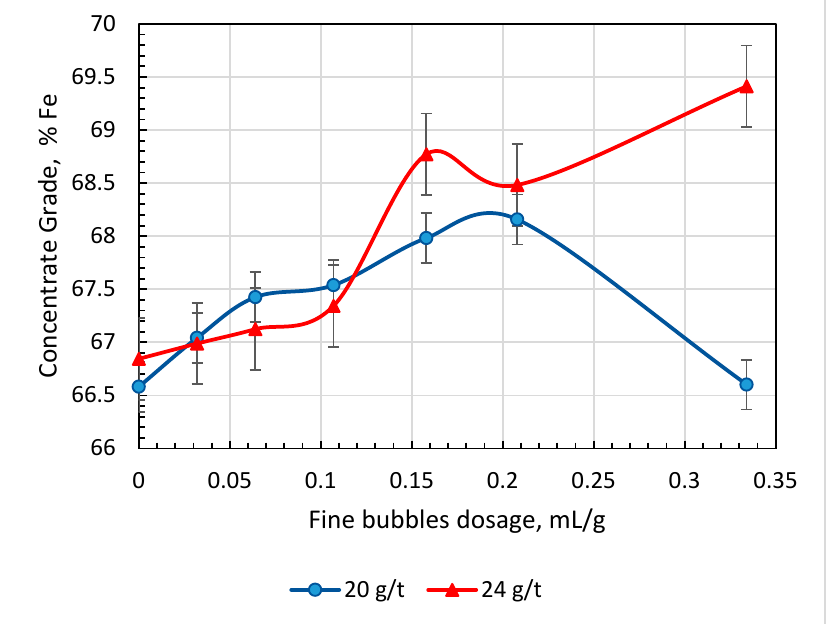
Figure 4. Dependence of concentrate grade on fine bubble dosage at the CTAB dosage of 20 and 24 g/t. Treatment time—7.5 s; TFR diameter—6 mm. (Error bars represent the standard deviation obtained from 3 test repeats).